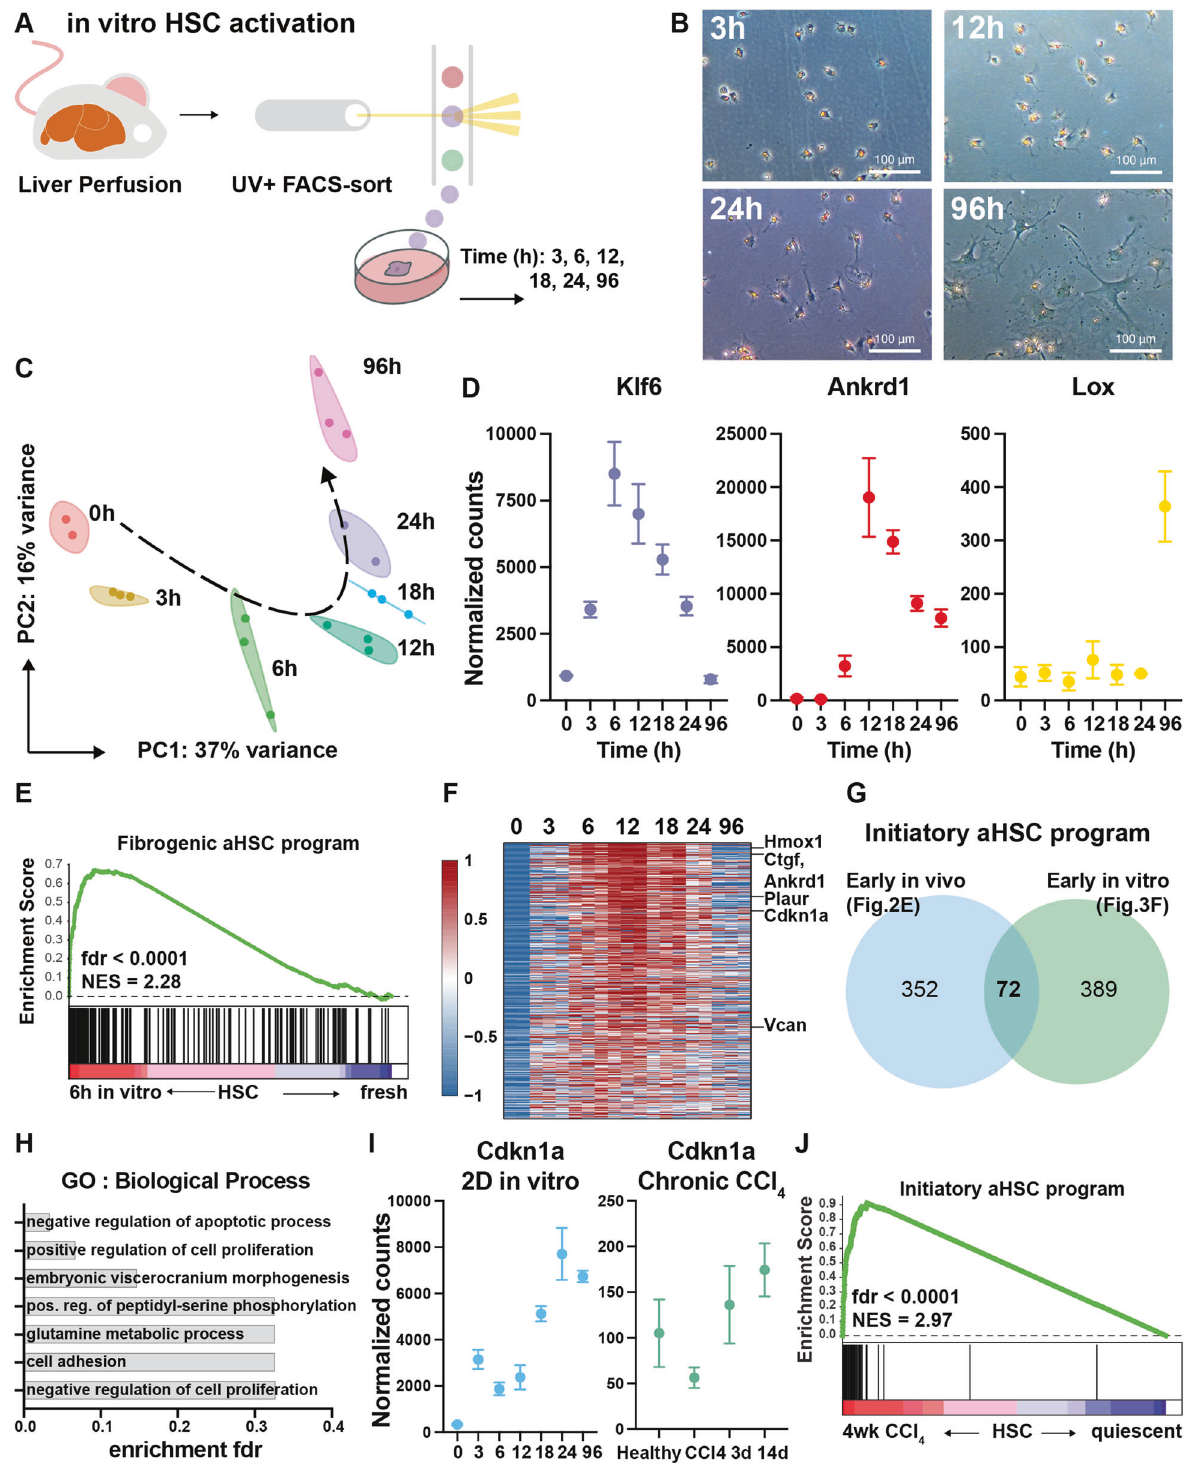
Fig. 3 De fi ning an initiatory aHSC transcriptional program from in vitro and in vivo initiating HSCs. A After liver perfusion and NPF isolation, HSCs were sorted into culture dishes using FACS. At indicated timepoints, cells were collected for RNASeq. B Bright fi eld microscopic images of 2D cultured HSCs. C PC analysis of in vitro activated HSCs. D Gene expression of canonical initiation genes Klf6 and Ankrd1 and fi brogenic gene Lox during HSC activation. E GSEA of HSCs cultured for 6 h compared to freshly isolated HSCs using the fi brogenic aHSC program de fi ned in Fig. 1. GSEA was performed with the “ gene set ” permutation type. F Heatmap of differentially upregulated genes in culture-activated mouse HSCs 6 h and 12 h after plating when compared to freshly isolated HSC. G To generate the initiatory aHSC program, the “ early in vivo ” (Fig. 2E) and “ early in vitro ” gene set were intersected (Fig. 4F). H GO analysis of the initiatory aHSC program. I Gene expression of Cdkn1a as example of dissimilarities between HSC initiation and perpetuation. J GSEA of HSCs isolated 24 h after 4week CCl 4 - induced liver fi brosis compared to qHSC using the initiatory aHSC program. GSEA was performed with the “ gene set ” permutation type.